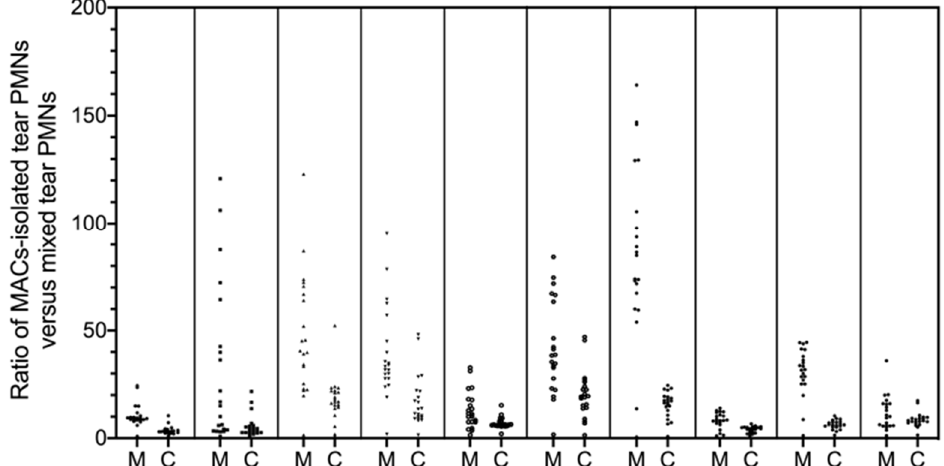
Figure 6. Comparison of ROS production by MACS-isolated tear PMNs and the non-isolated mixed tear PMNs. M: MACS-isolated tear PMNs; C: mixed tear PMNs from eye collection concentrated by centrifugation. Data points represented as the ratios of stimulated versus unstimulated CLU over 60 min at 3 min intervals. n = 10 from 10 different individuals, each presented in individual column.